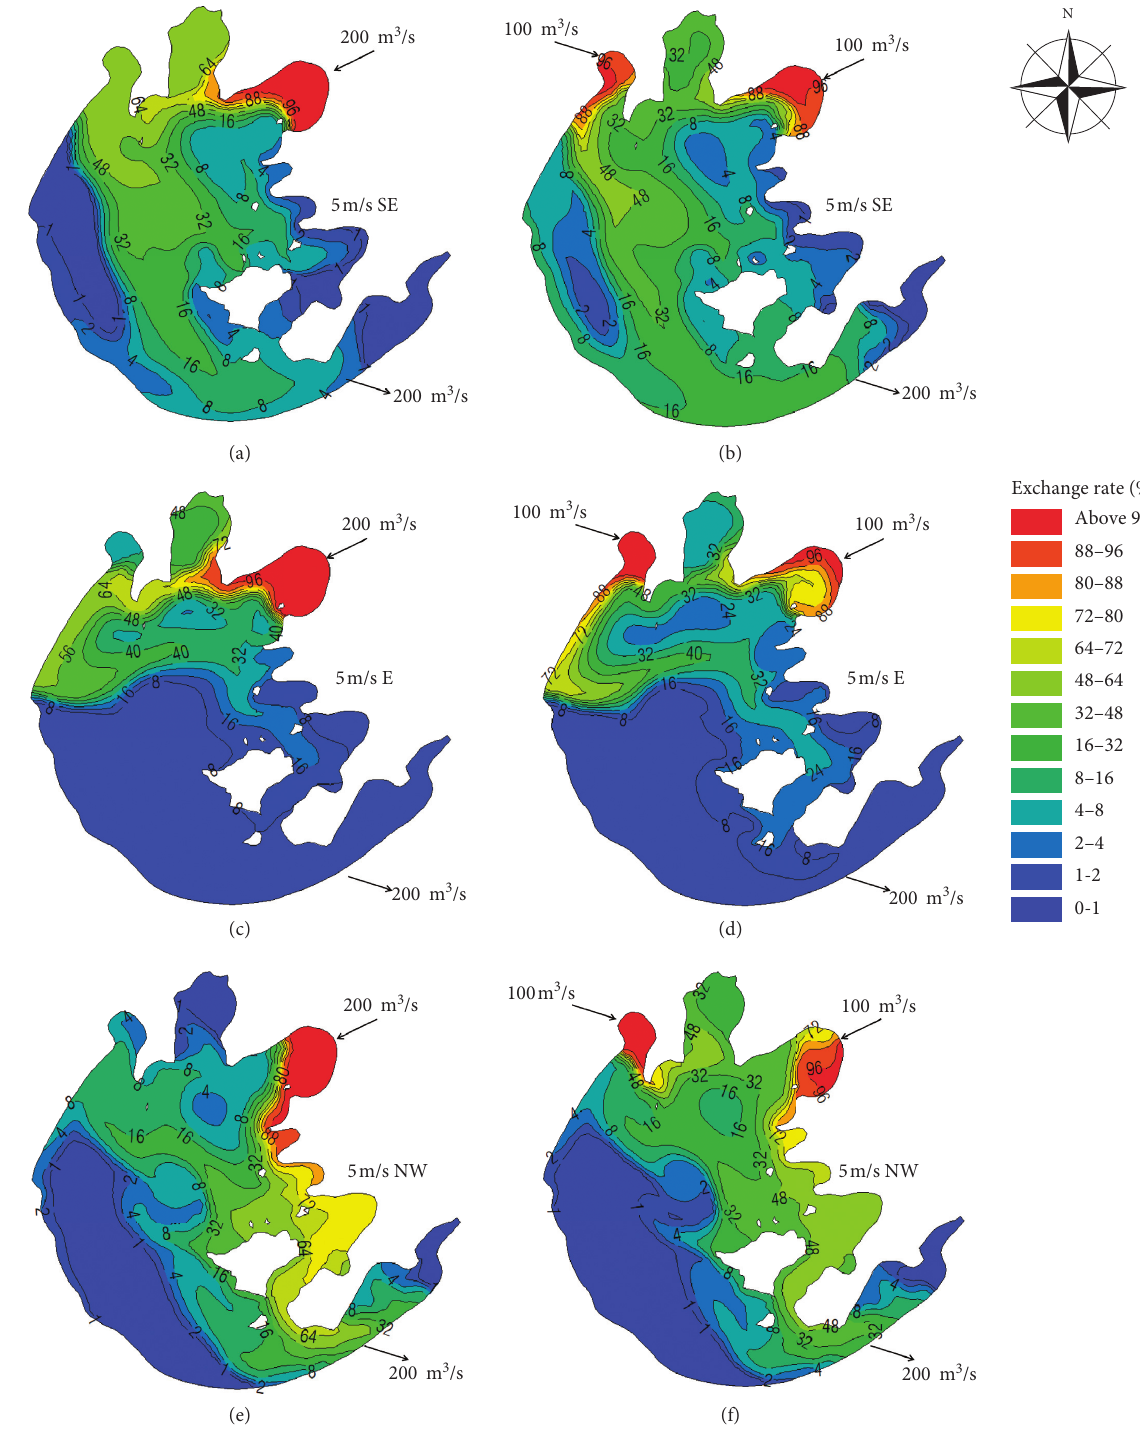
Figure 8: Water exchange rate simulation results for operating modes